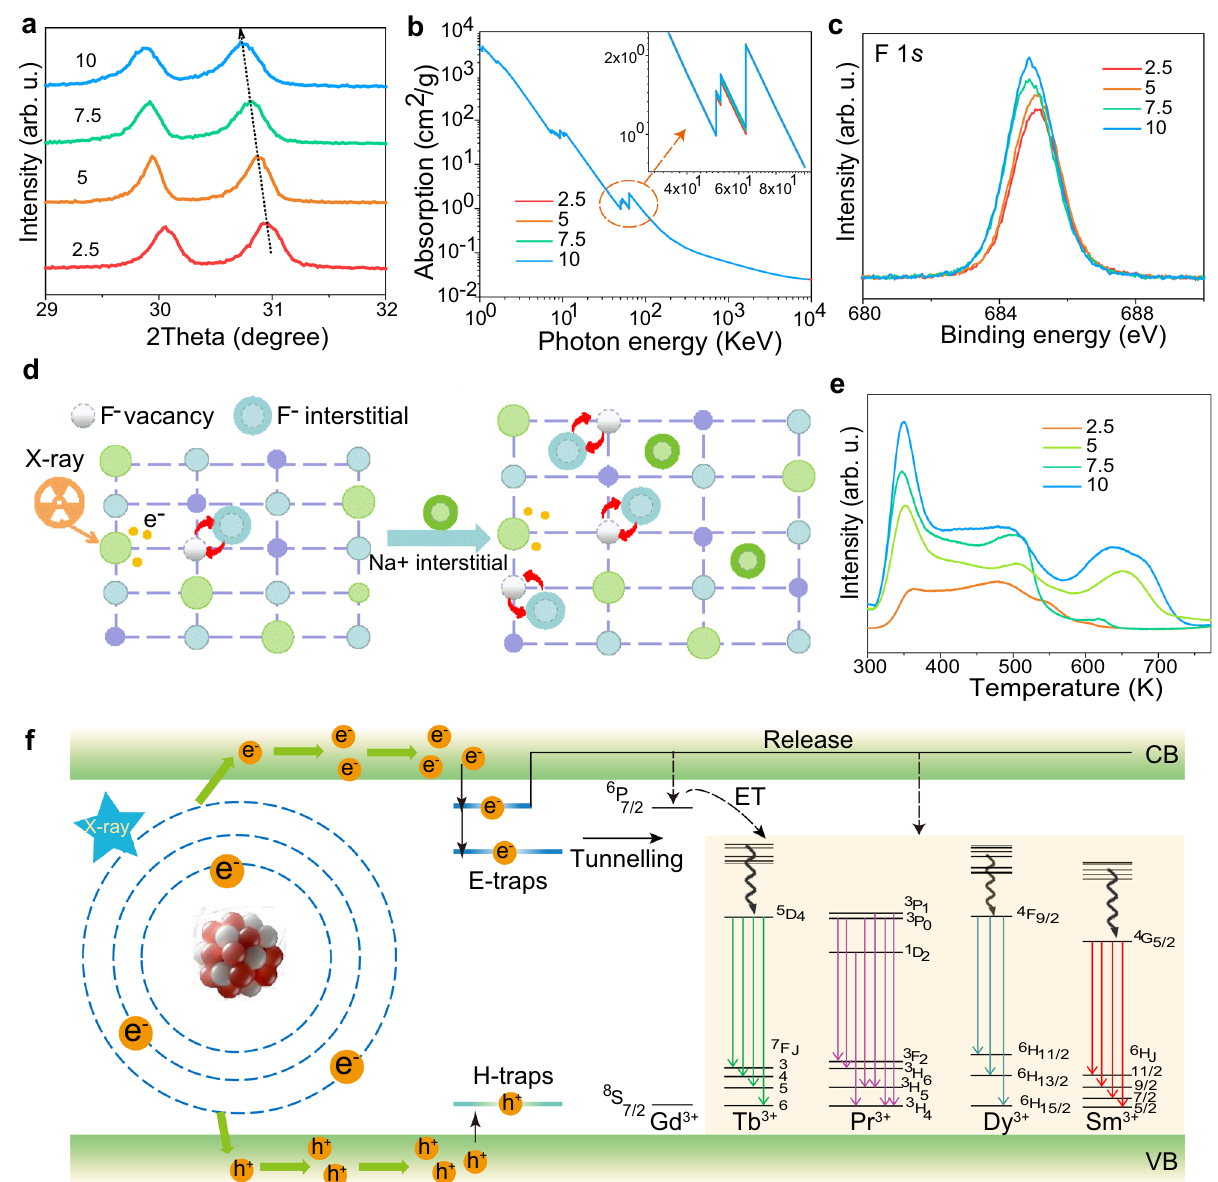
Fig. 3 | Mechanistic investigations of the improved XEOL and XEA. a Zoom-in XRDpatternsoftheNaLuF 4 :Gd/TbNPspreparedwithdifferent[Na]/[RE]ratiofrom 29 to 32°. b Absorption spectra of the NaLuF 4 : Gd/Tb NPs prepared with different [Na]/[RE] ratio as a function of X-ray energy. XPS spectra of F 1 s ( c ). d Schematic illustrationforincreasedFrenkeldefectsaftertheintroduceofNa + interstitialupon